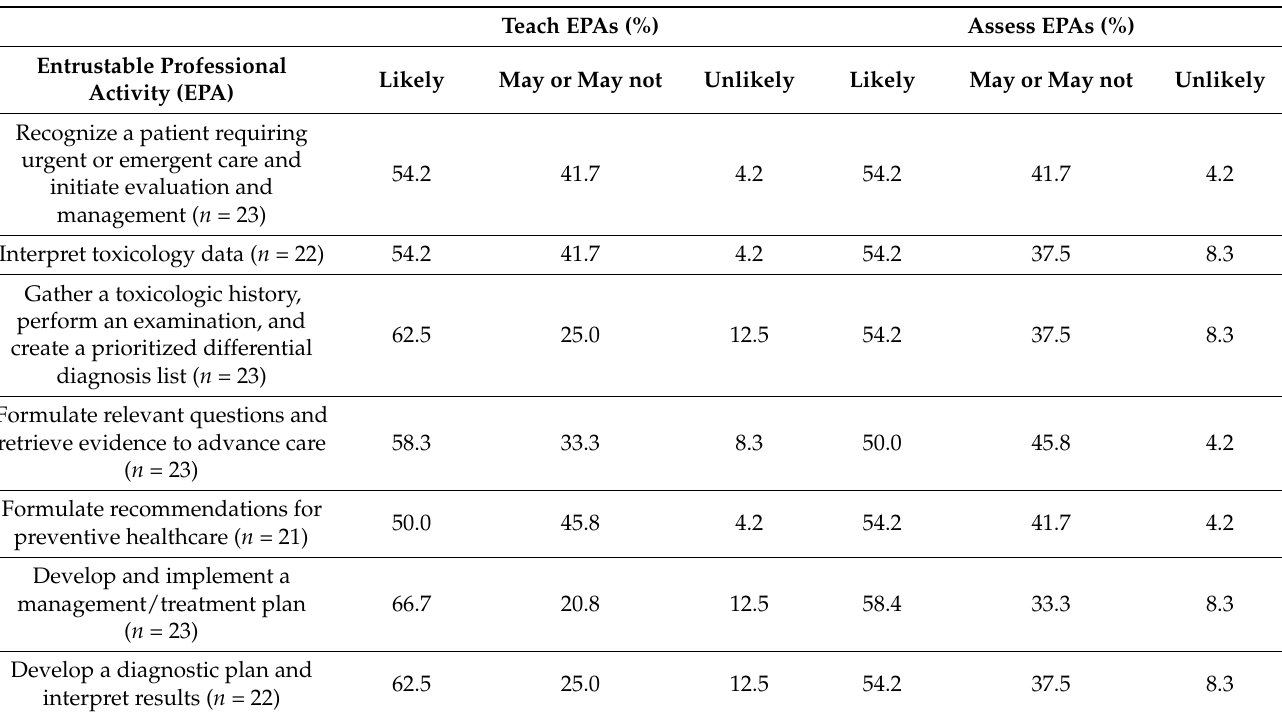
Table 4. Respondent’s likely use of online, peer-reviewed materials to either teach or assess EPAs (number of responses varies per